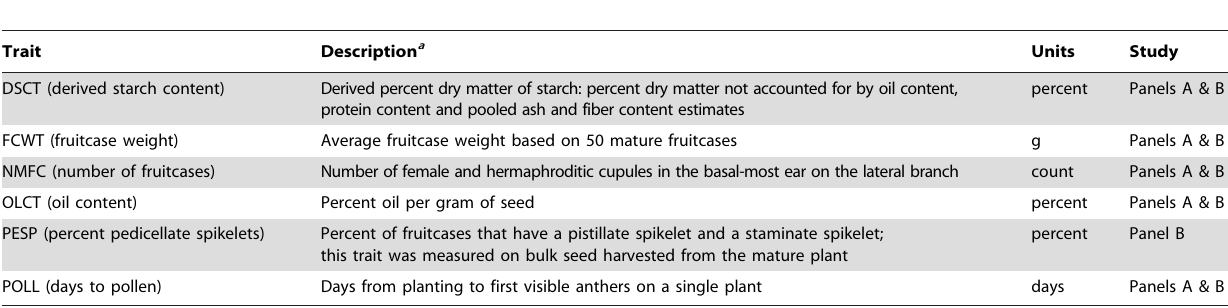
Table 1. List of traits with repeated associations or associations that survive correction for multiple